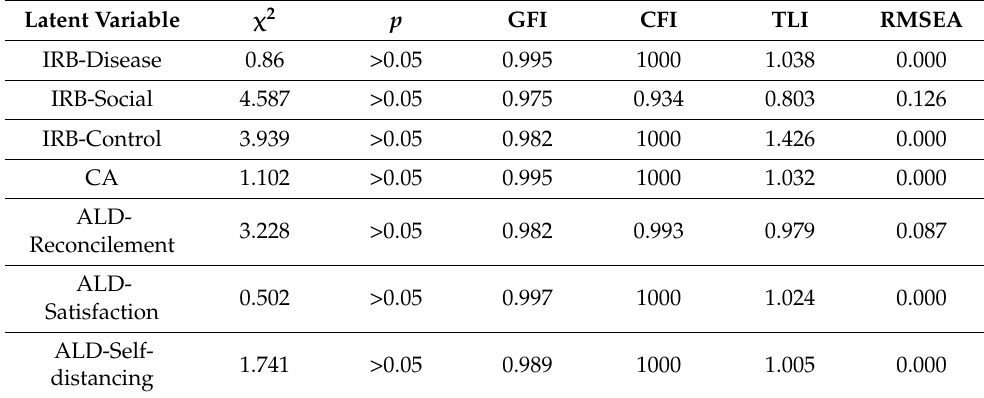
Table 1. Confirmatory factor analytic results for the development of latent variables.